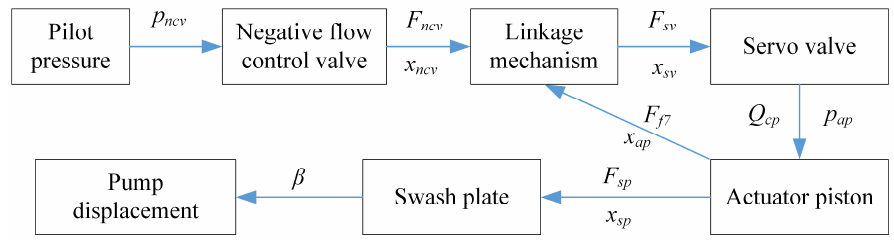
Figure 7. Flow chart of the power control.